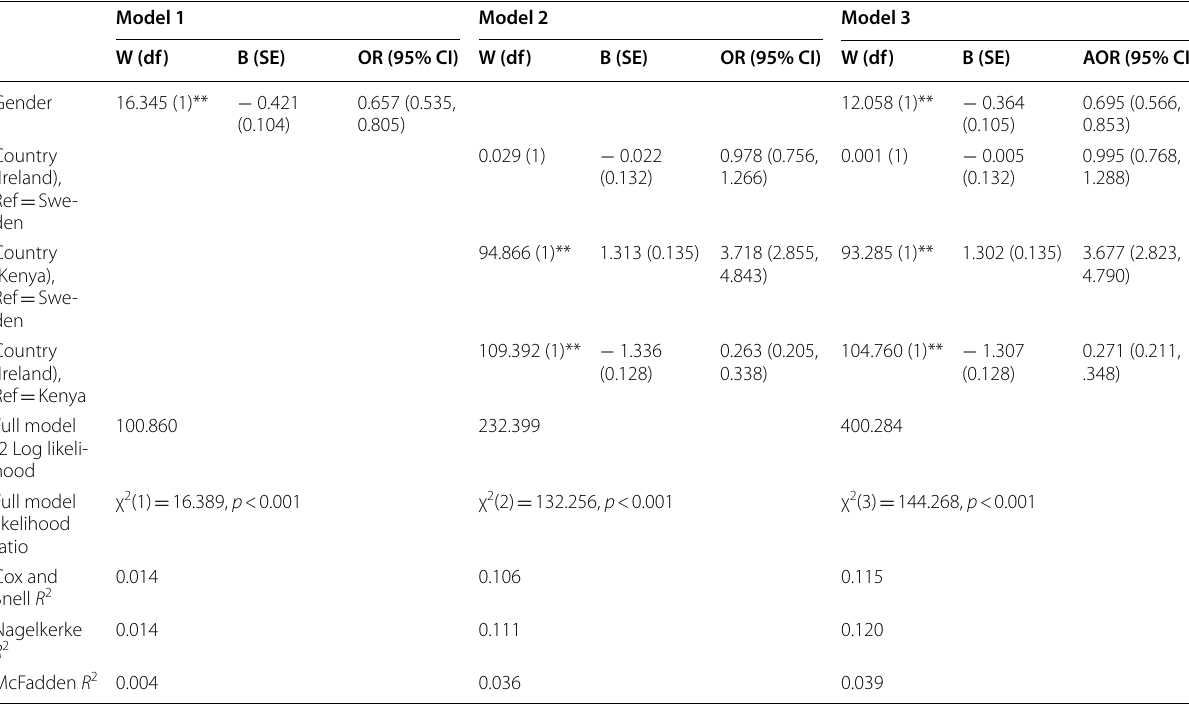
Table 7 Ordinal regression with interest in becoming an engineer as the dependent